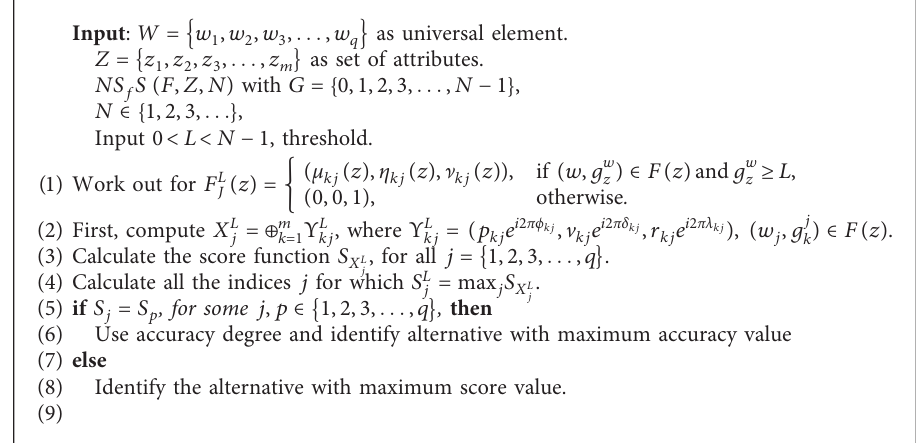
A LGORITHM 4: The algorithm of L -choice values of CSFNS f Ss Five diamonds mean “Marvellous” Four diamonds mean “Outstanding” Three diamonds mean “Super” Two diamonds mean “Good” One diamond means “Satisfactory” Big dot means “Acceptable.”